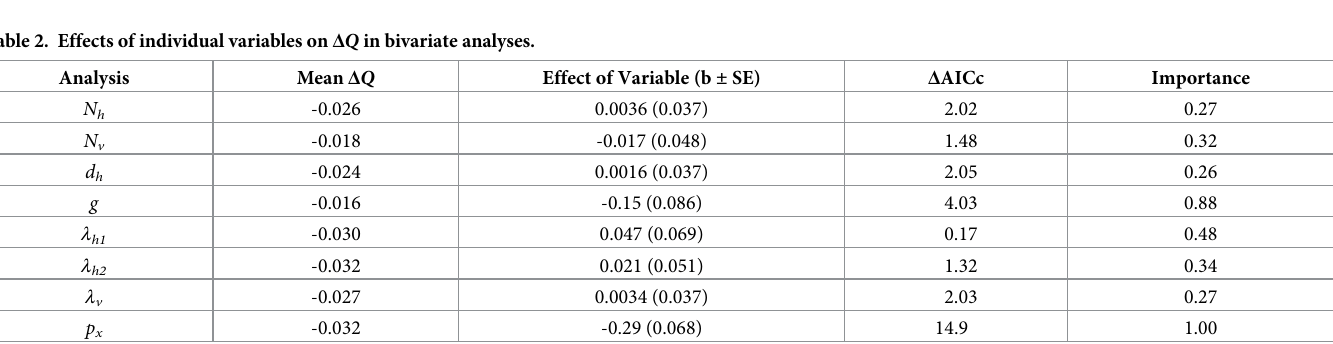
Table 2. Effects of individual variables on Δ Q in bivariate